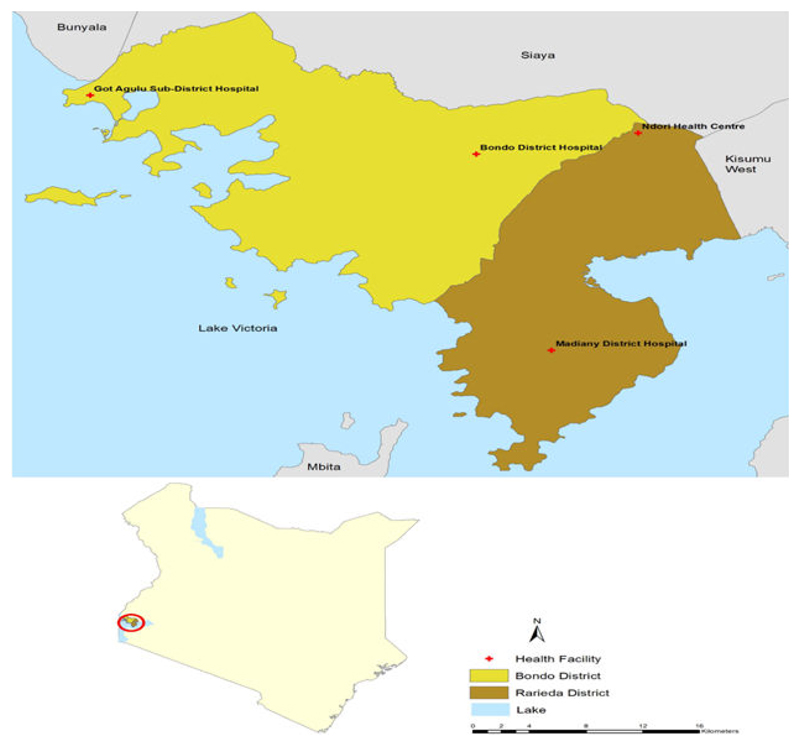
All trial sites.